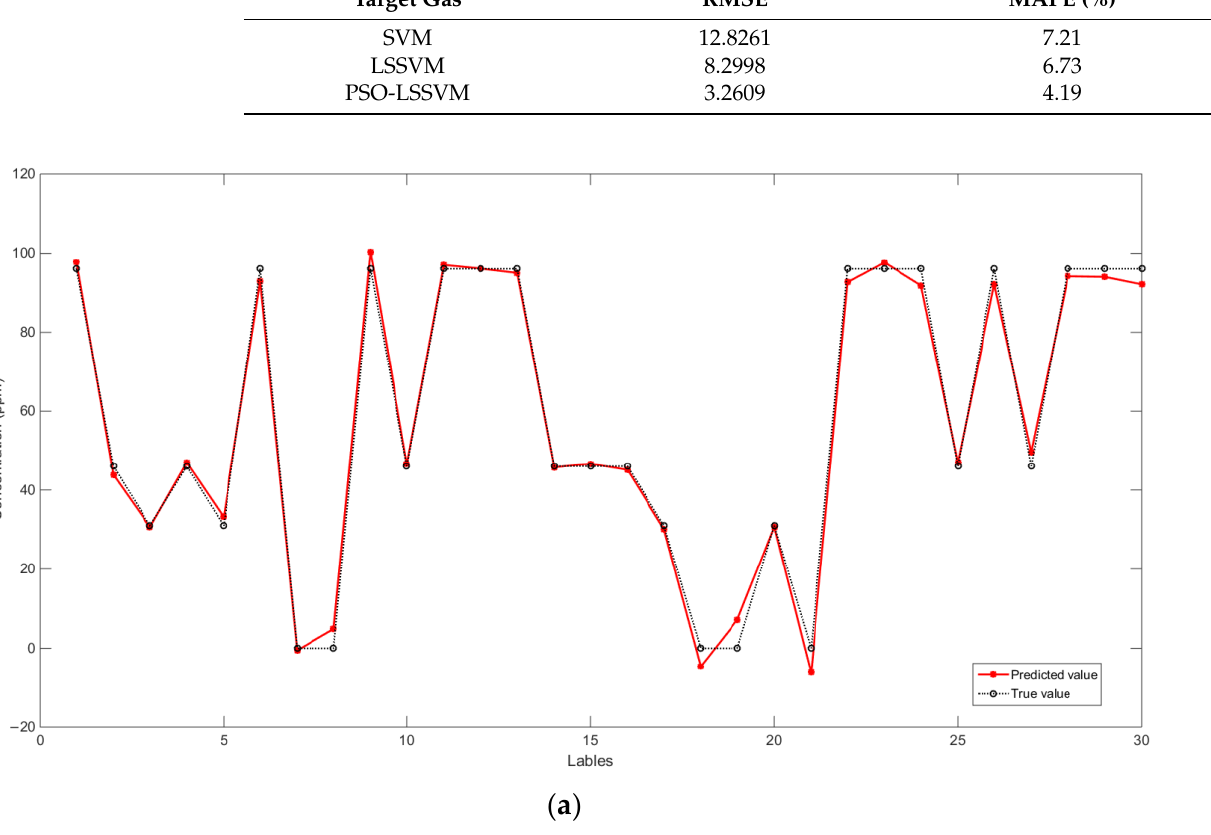
Table 12. Concentration prediction results of ethylene gas in mixed gas using different concentra- tion prediction methods.